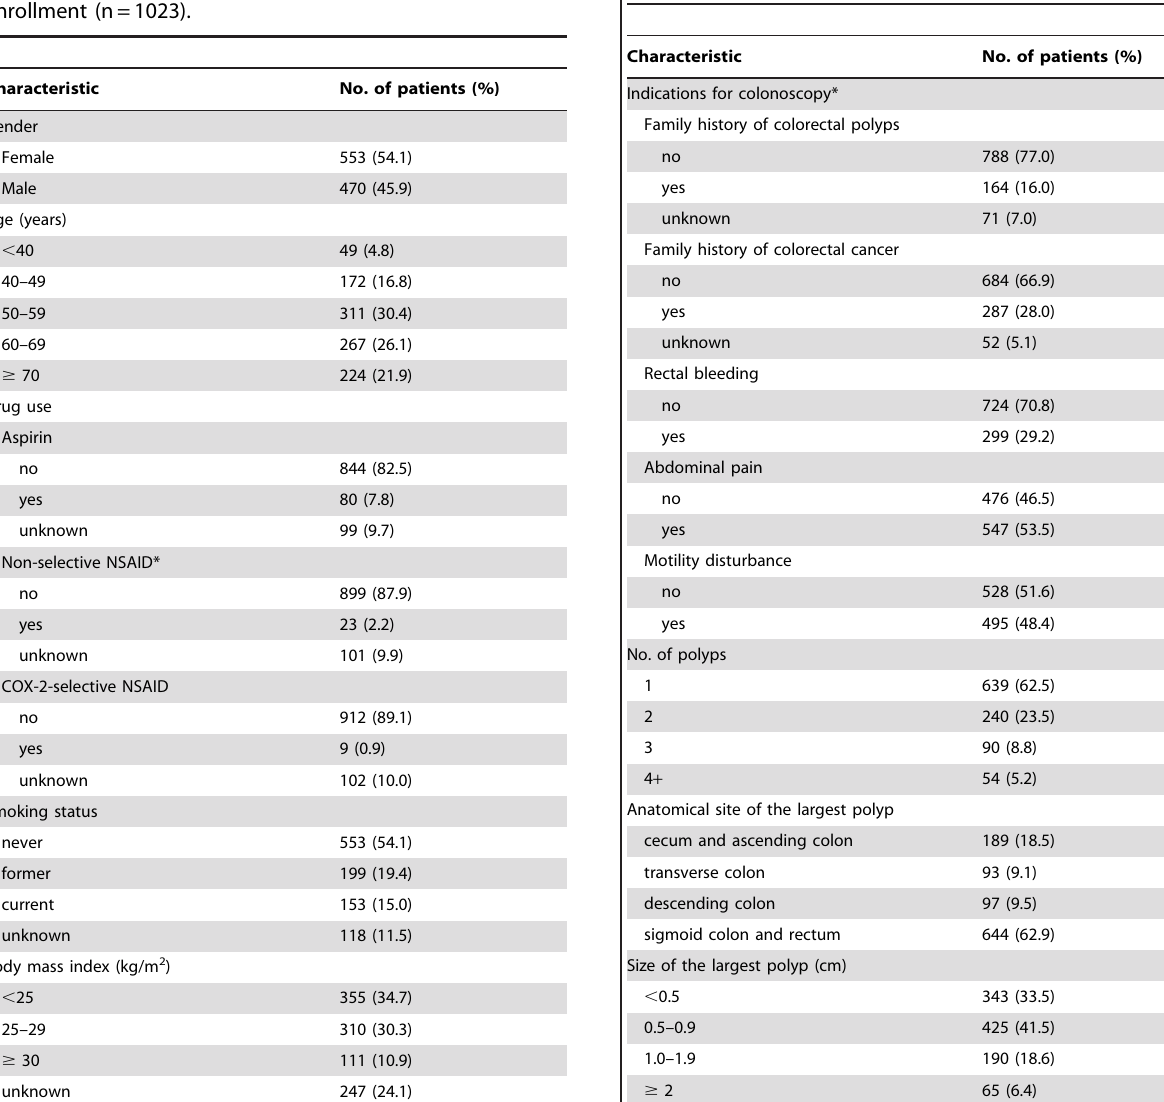
Table 2. Patient clinical characteristics at enrollment